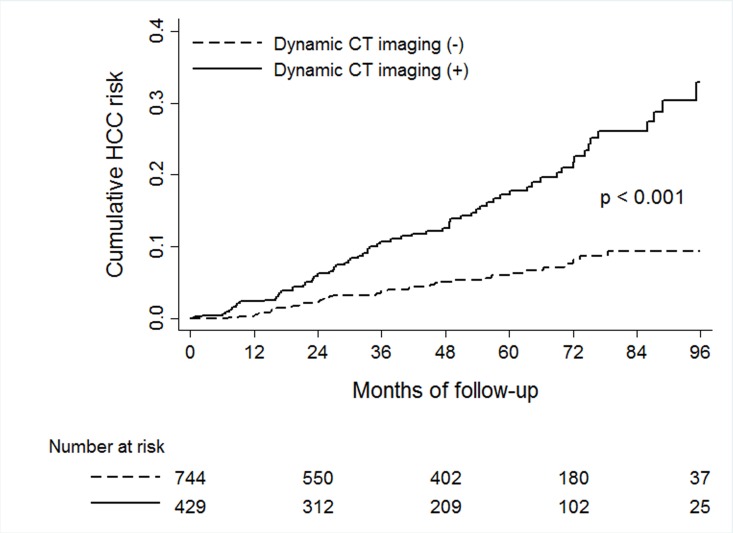
Kaplan-Meier analysis of HCC incidence in the derivation cohort.